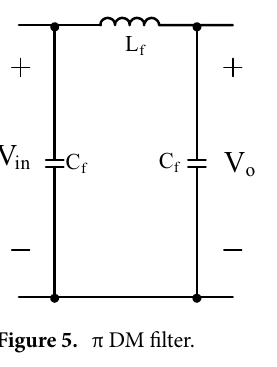
Figure 5. π DM filter.